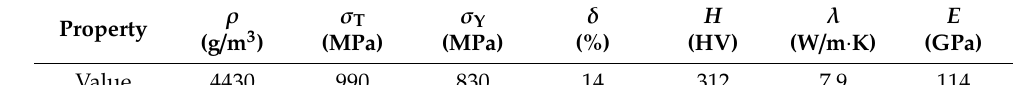
Table 2. Mechanical properties of Ti6Al4V.